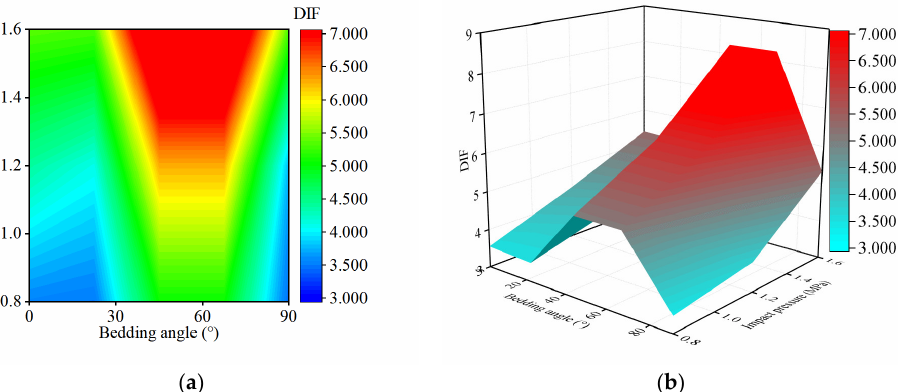
Figure 8. Dynamic strength growth factor of sandstone under different loading conditions. ( a ) Two- dimensional cloud map of the dynamic strength growth factor for sandstone; ( b ) 3D cloud image of the dynamic strength growth factor for sandstone.